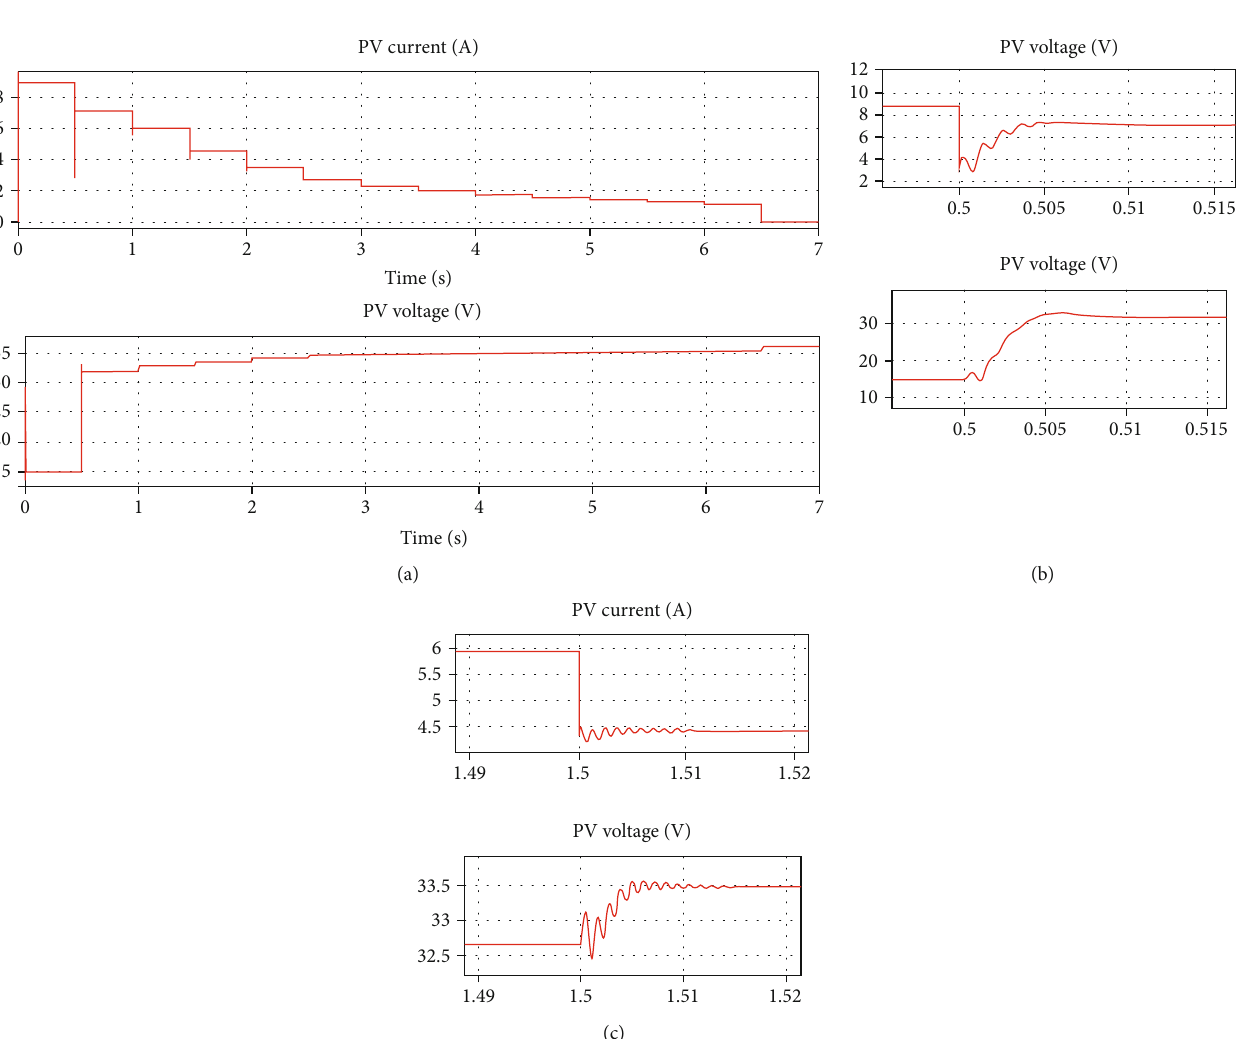
Figure 9: Summary of ANN